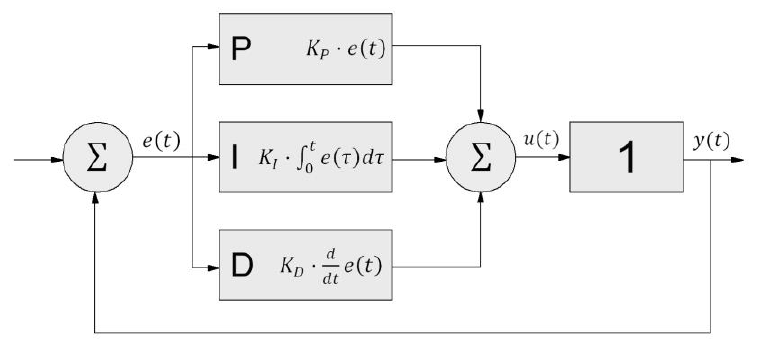
Figure 2. General diagram of PID (Proportional–integral–derivative) controller.